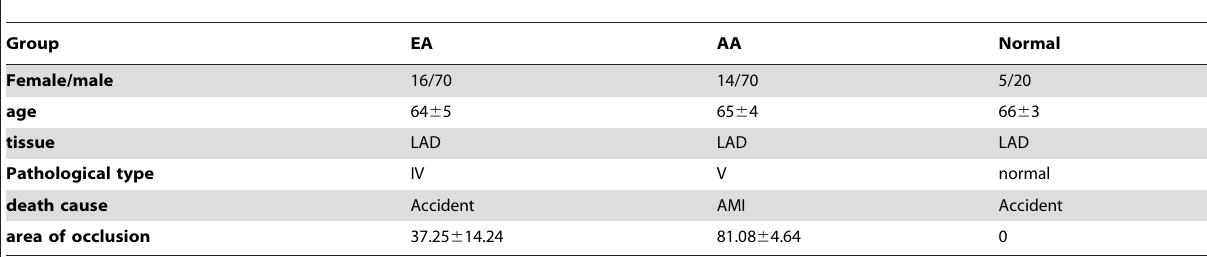
Table 1. Characteristics of the samples included in this